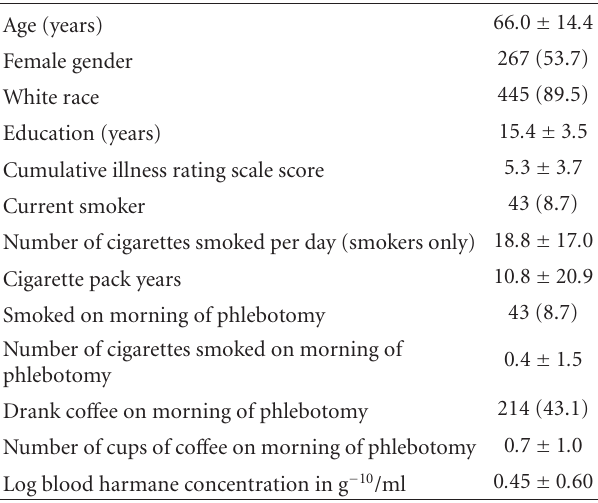
Table 1: Characteristics of 497 study